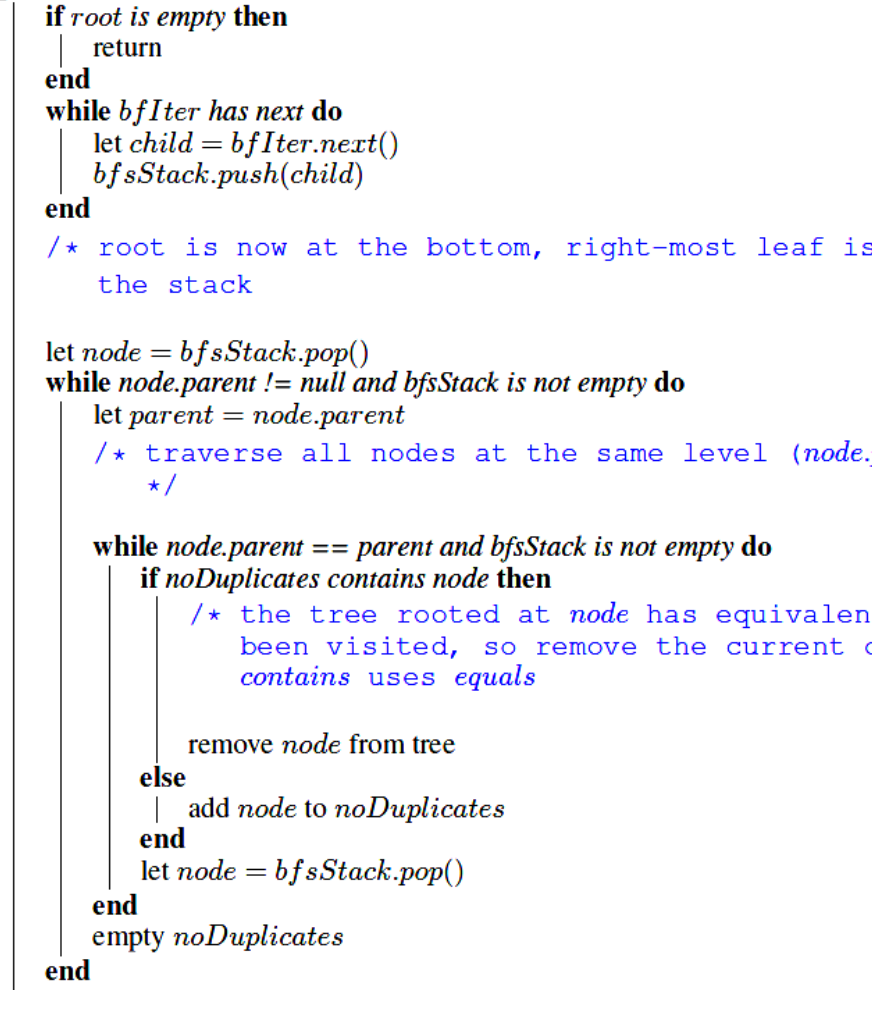
Figure 6. Tree Structure Inference Algorithm (Algorithm